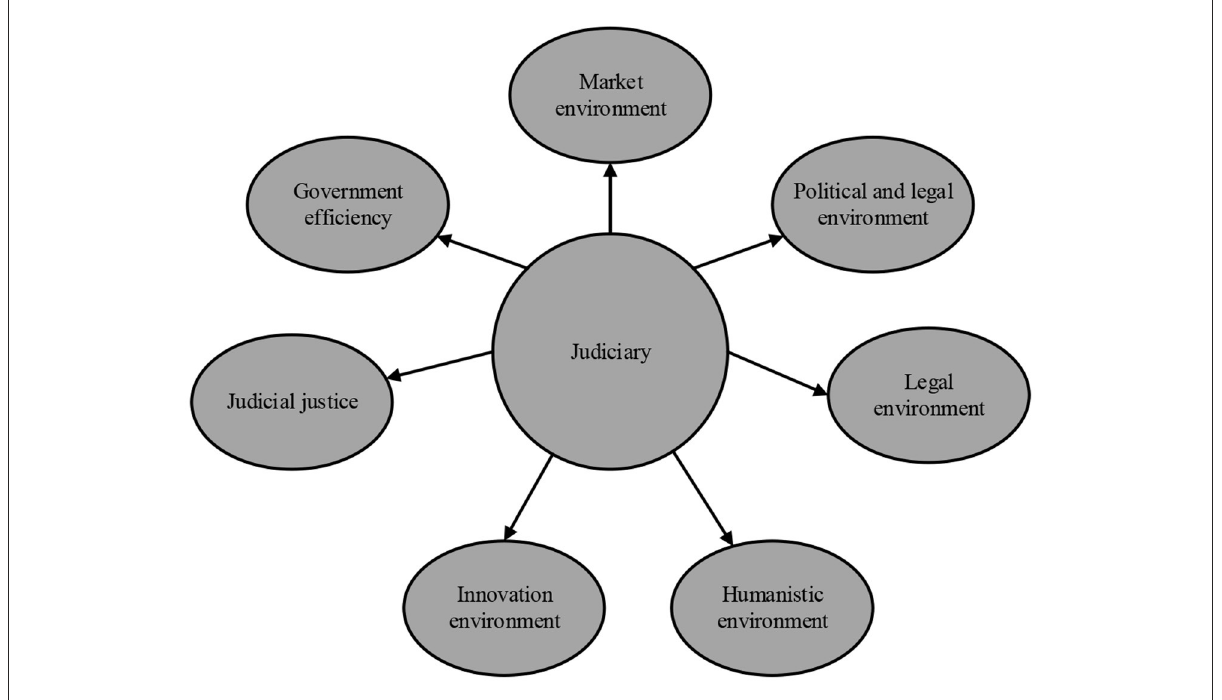
FIGURE2 The CLR-based business environment optimization